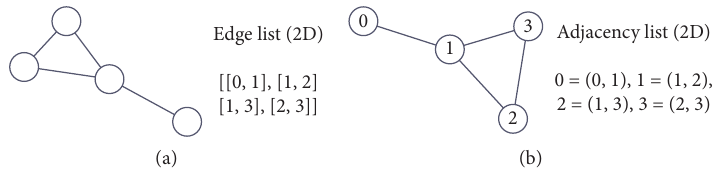
Figure 2: Schematic representation of the edge list (a) and the adjacency list (b).